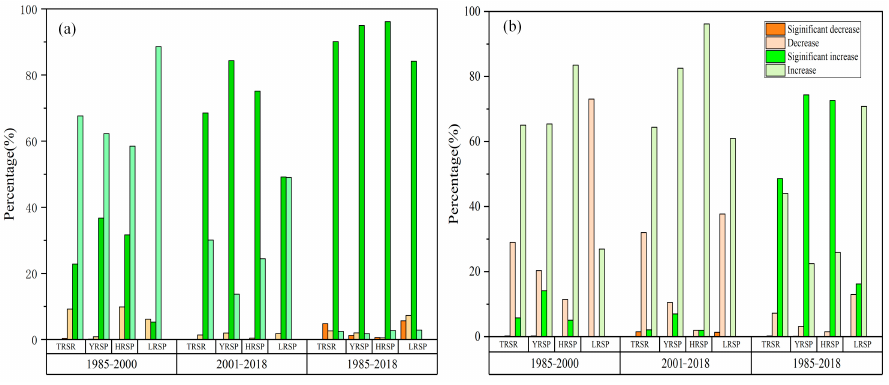
Figure 8. Area percentages of changes in GPP ( a ) and NEP ( b ) in different regions.